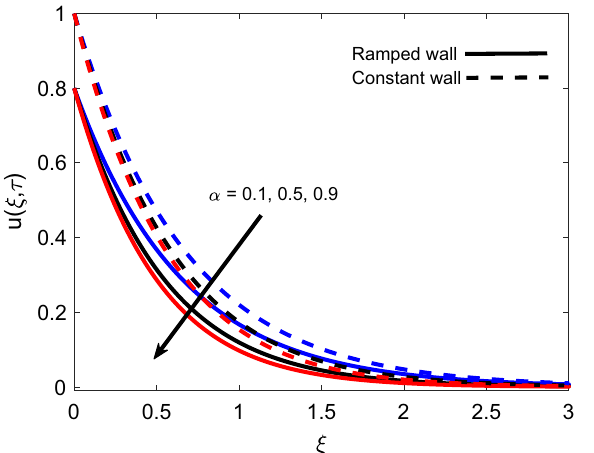
Figure 10. Velocity distribution for various values of α .